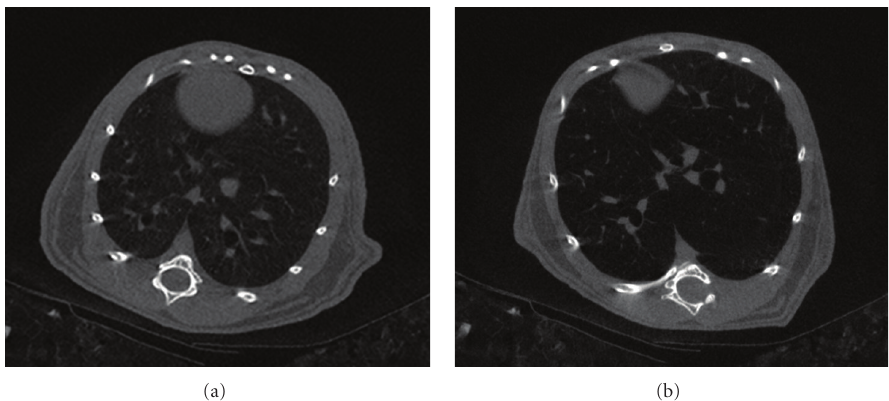
Figure 2: Sample transversal mouse lung micro-CT slices 17 days after instillation. (a) Control. (b) Elastase treated. Both slices are calibrated in Hounsfield units and displayed with a 2500 window centered at a level of zero. Note how the lung of the elastase-treated animal appears darker than the control lung.